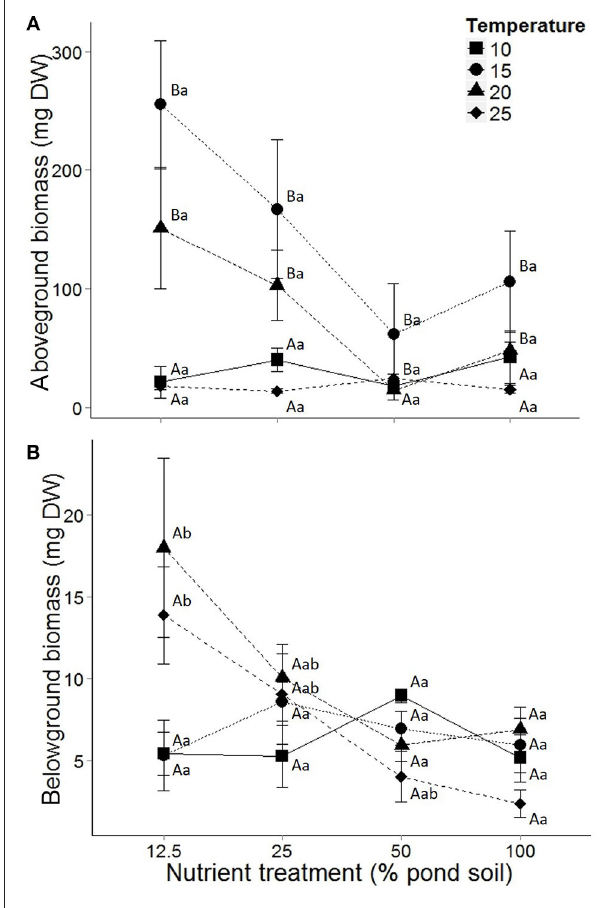
FIGURE 1 | Above—(A) and belowground (B) biomass of Elodea nuttallii grown at different temperatures and sediment nutrient content. Temperature treatments include 10 ( (cid:4) ), 15 ( • ), 20 ( N ) and 25 ( (cid:7) ) ◦ C. Dots represent means and error bars standard error of the mean ( n = 5). Capital and lower case letters indicate post-hoc differences between temperature and nutrient treatments,